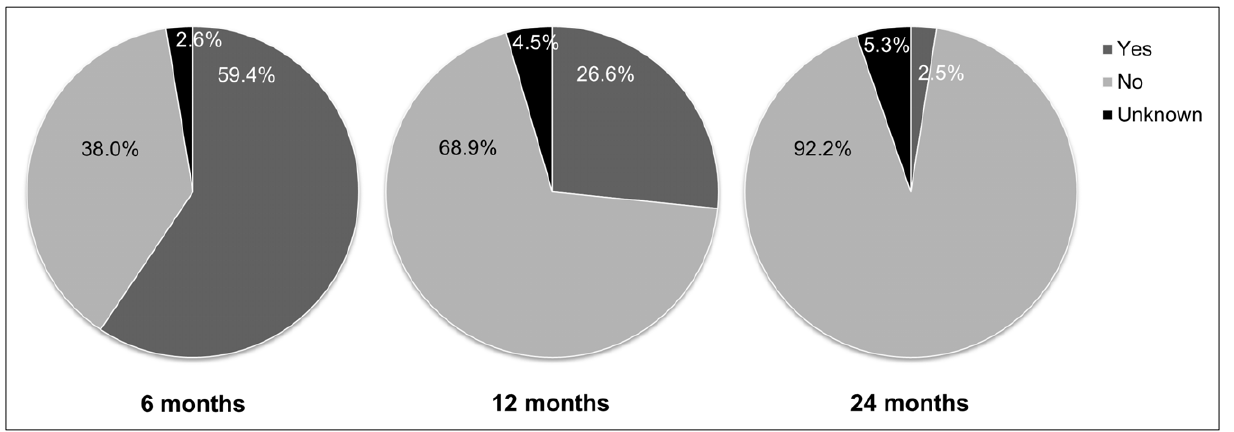
Figure 1. The proportion of Australian children (N=9773) who were breastfed according to national and international duration targets of six, 12, and 24 months or more. a Unknown: breastfeeding was ongoing at the time of the survey and the duration target had not